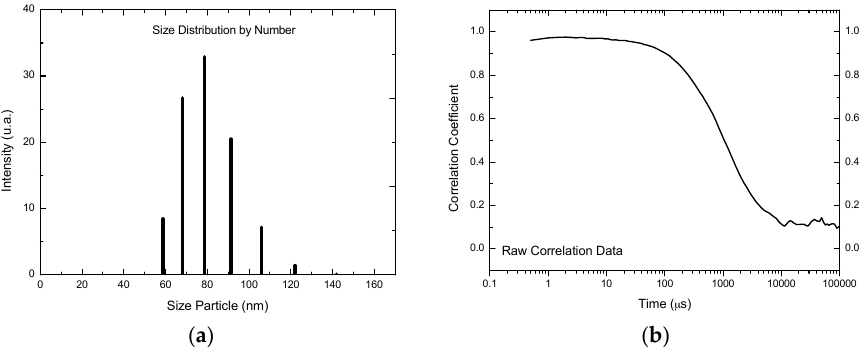
Figure 3. ( a ) Zirconia nanoparticles size distribution; ( b ) Raw correlation coefficient.